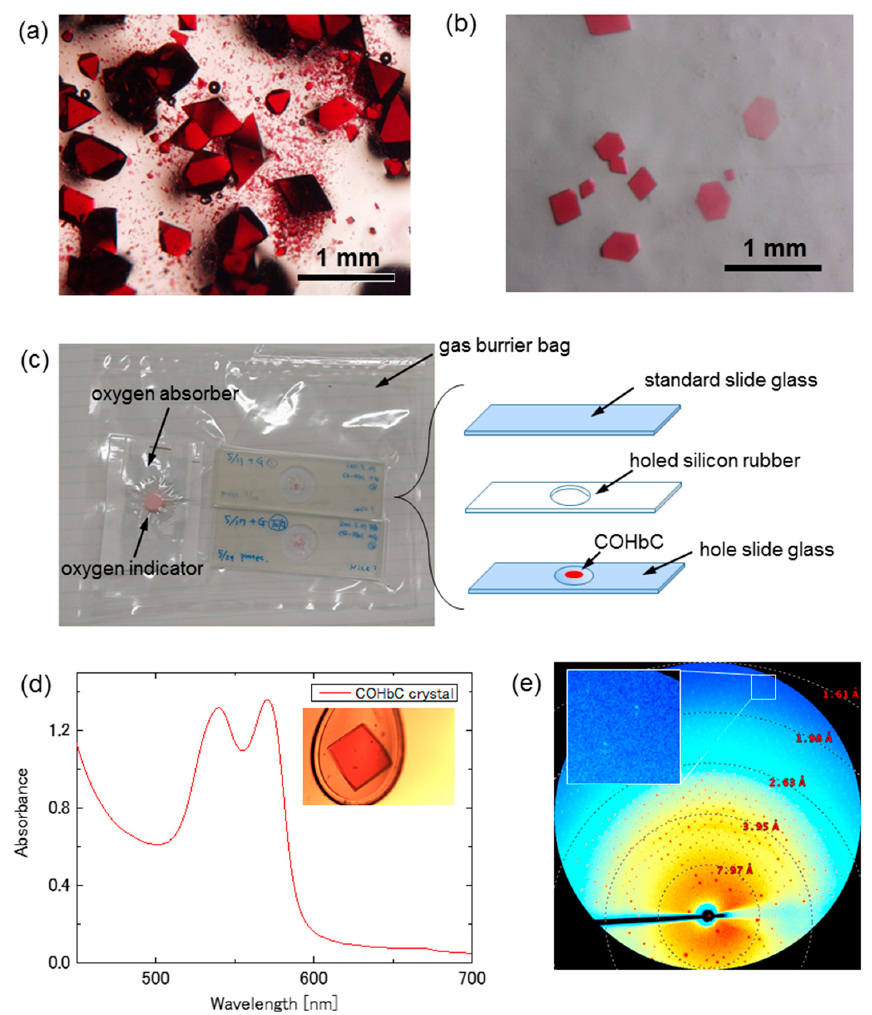
Figure 2. High quality, thin R-state COHbC crystals for X-ray crystallography (XRC) combined with CO photolysis and/or spectrophotometry. ( a ) COHbC crystals obtained by a conventional batch method; ( b ) Shape-controlled thin COHbC crystals; ( c ) Shape control approach using a spatially restricted crystallization; ( d ) Typical absorption spectrum of the shape-controlled thin COHbC crystal at 120 K. Inset is a photograph of the measured crystal; and, ( e ) An X-ray diffraction pattern of the same COHbC crystal as used for the spectral measurement. Diffraction spots are visible up to 1.7 Å.